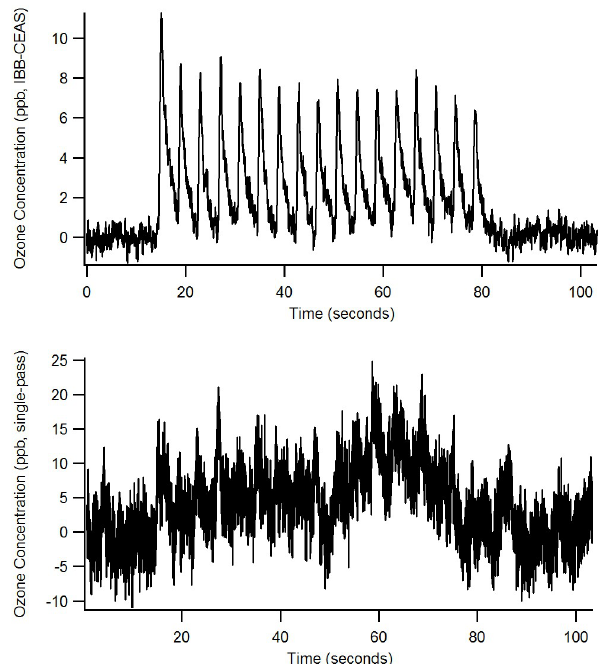
Fig. 3. Simultaneous IBB-CEAS (top) and single-pass (bottom) transmission measurements taken at 0.01s integration, of periodic ozone concentration spikes generated from discrete Hg lamp pulses.